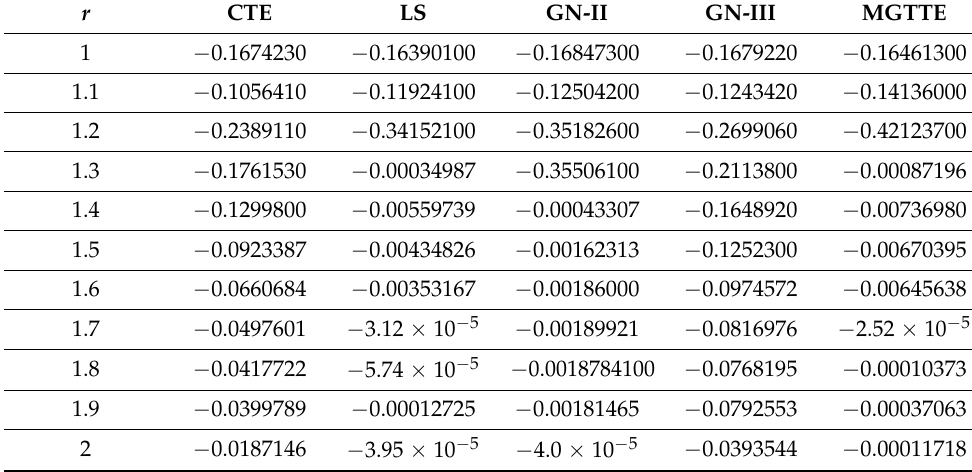
Table 4. The hoop stress, σ ξξ , versus different models of thermoelasticity.